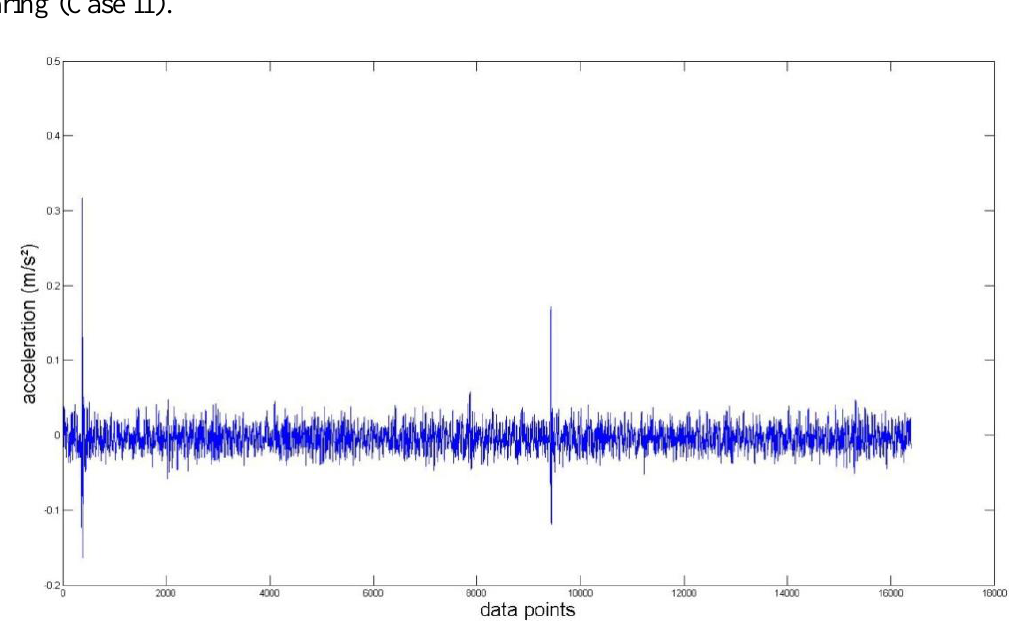
Figure 7. Vibration data points after applying only MED signal processing on a damaged bearing (Case II).